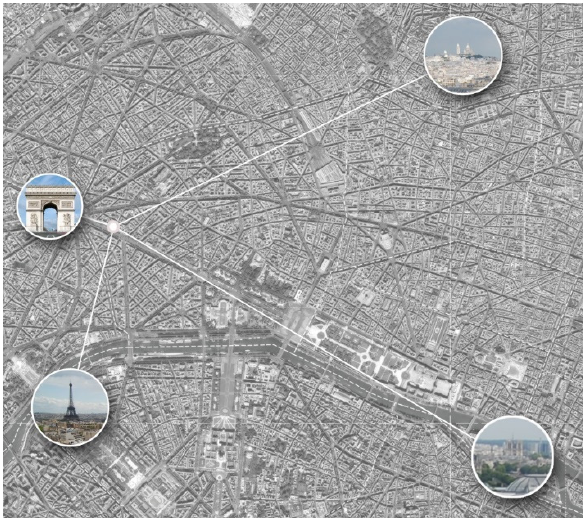
Figure 2. The location of important places on the map of Paris impacted the Beistegui apartment